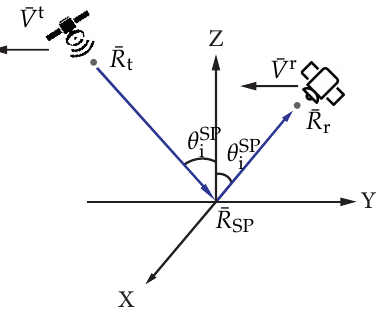
Figure 2. SP geometry, ¯ R t is the transmitter position, ¯ R r is the receiver position and R SP is the SP